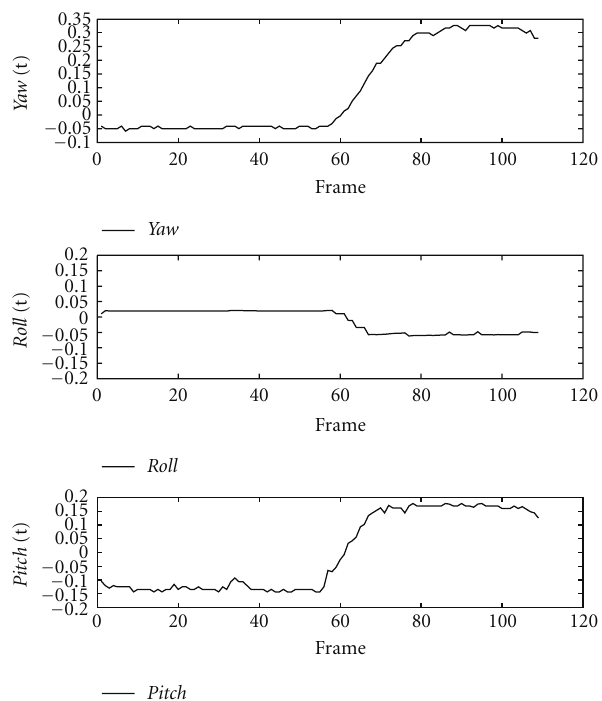
Figure 9: Example of sequential face orientation data when the user turns his face from frontal to lower right.